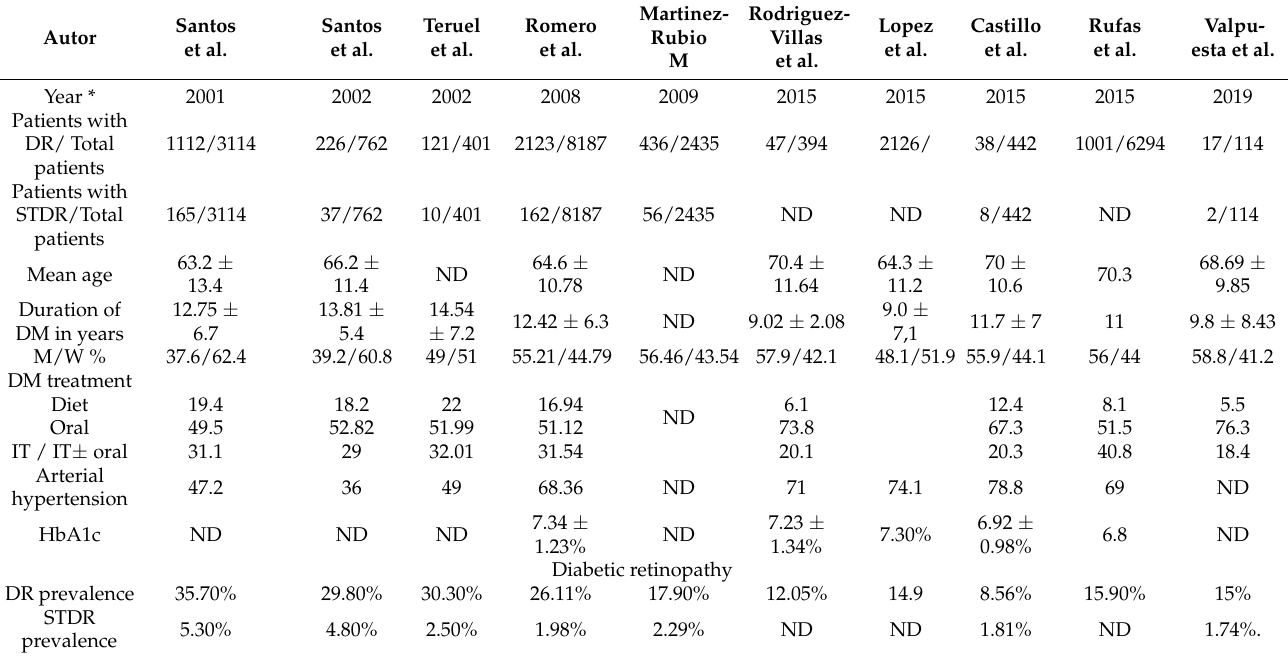
Table 1. Diabetic retinopathy outcomes and demographic data from cross-sectional